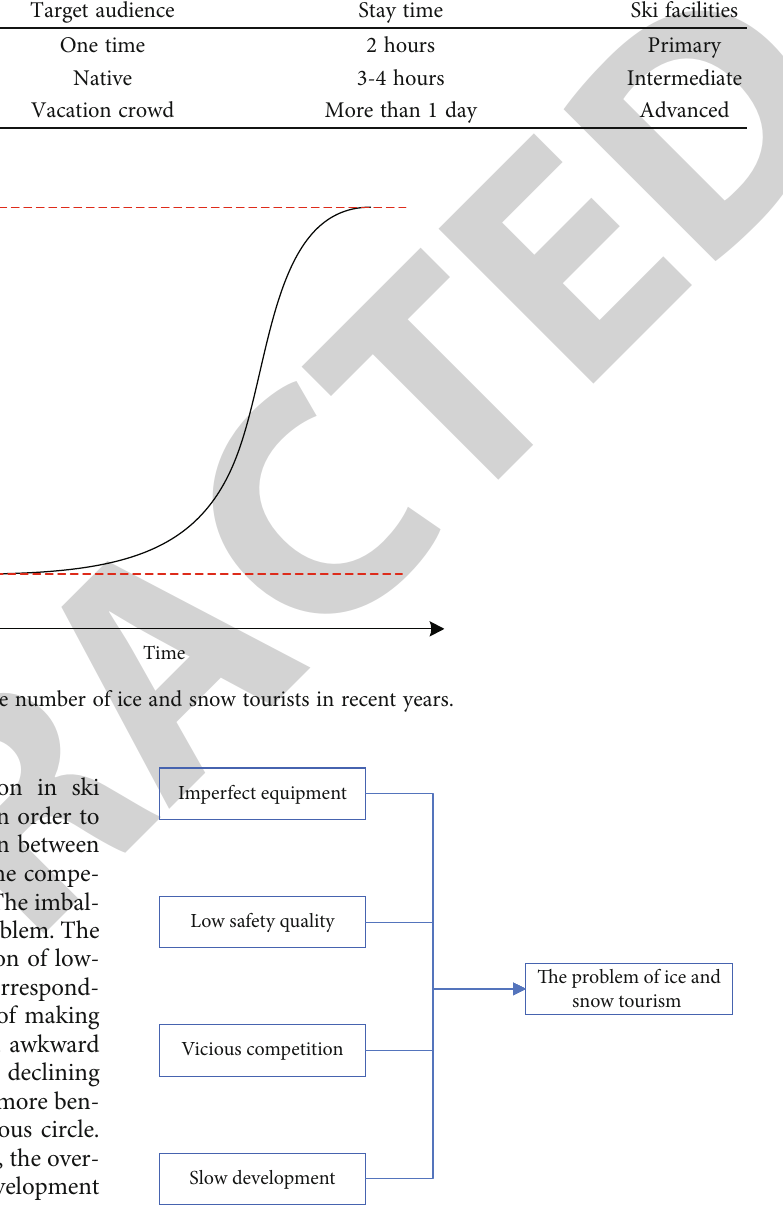
Figure 4: Factors a ff ecting the development of ice and snow